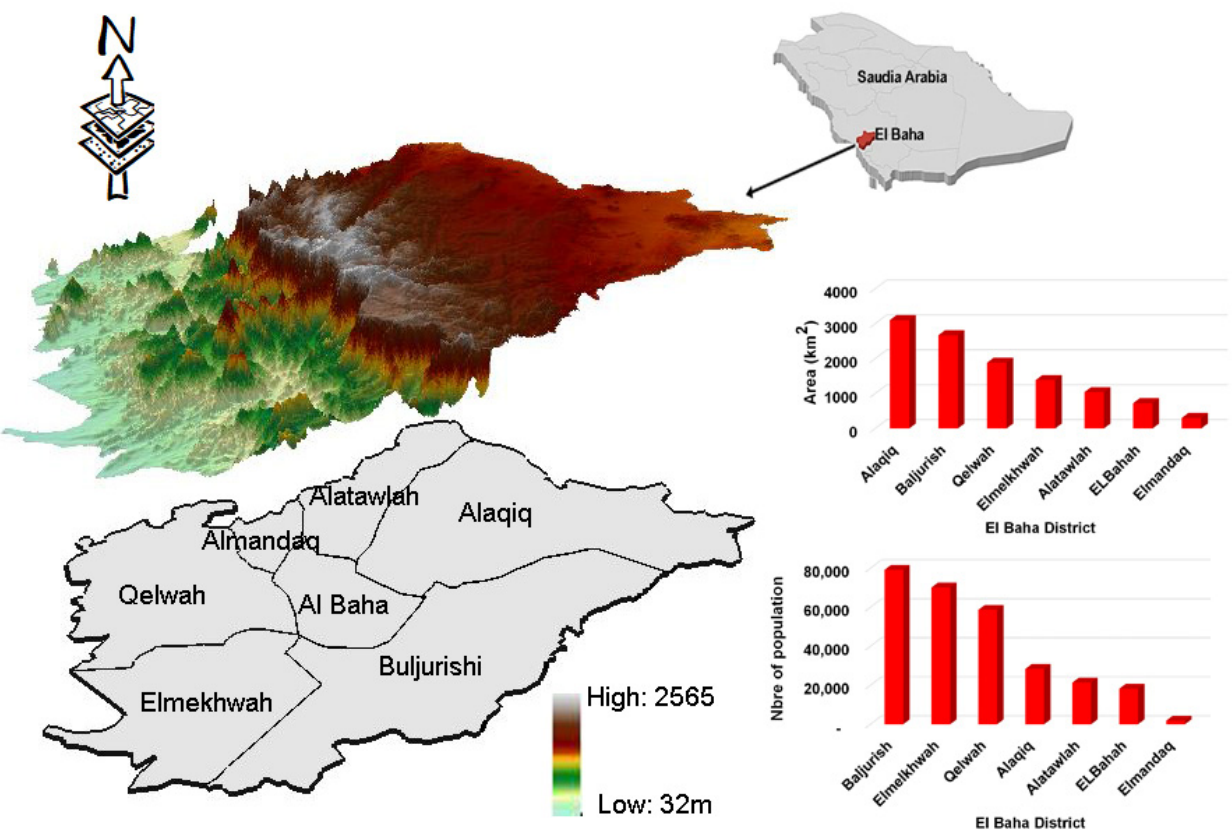
Figure 1. Digital elevation model in 3D and geographic location of the study area and an overview of the number of population and area of each district of the study region.